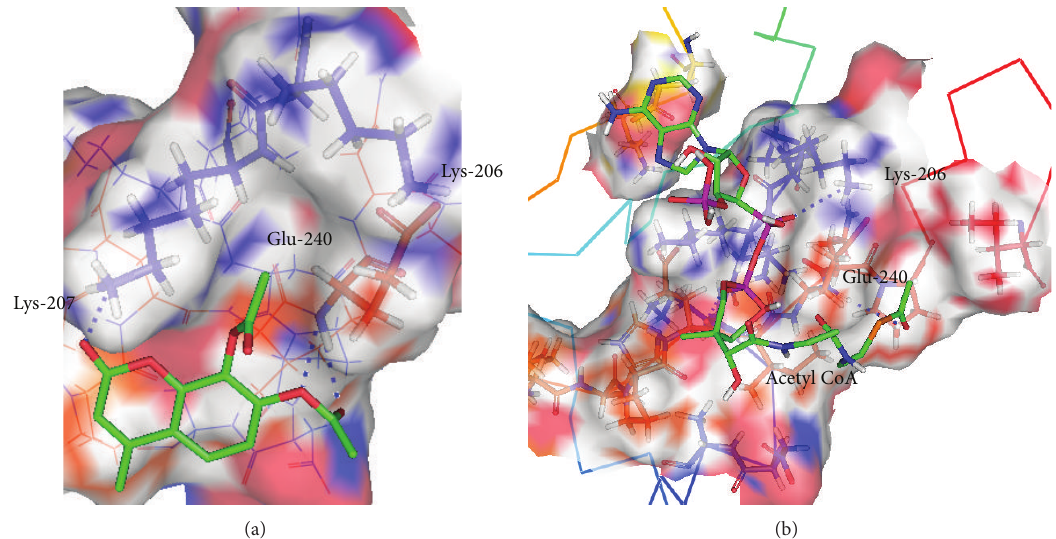
Figure 2: Proposed docking conformation of DAMC and acetyl CoA to the binding site (P-domain) of the 3D model structure of human CR. Basic and acidic amino acid residues are shown by blue and red colors, respectively. (a) DAMC (colored in standard atom color) forms H-bond interaction (blue dashed line) with 𝜀 -amino group of Lys-207 with its C-2 carbonyl oxygen and C-7 heteroatom oxygen, and carbonyl oxygen forms H-bind with backbone NH of Glu-240. (b) Carbonyl oxygen of acetyl group attached to the thiol group of CoA is hydrogen bonded with backbone NH of Glu-240, and 𝜀 -NH 3 hydrogen atom of Lys-206 forms hydrogen bond with phosphate oxygen of CoA. The figure was prepared by Pymol software